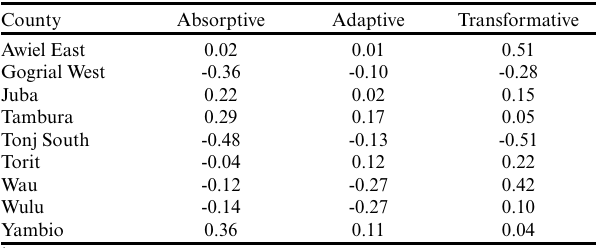
Table 4 . Average z-score values for each category of resilience, as organized at the county level, for the Fortifying Equality and Economic Diversification (FEED) Project dataset, 2015.